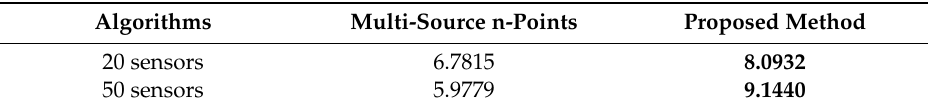
Table 3. Cuto ff distance of di ff erent clustering methods